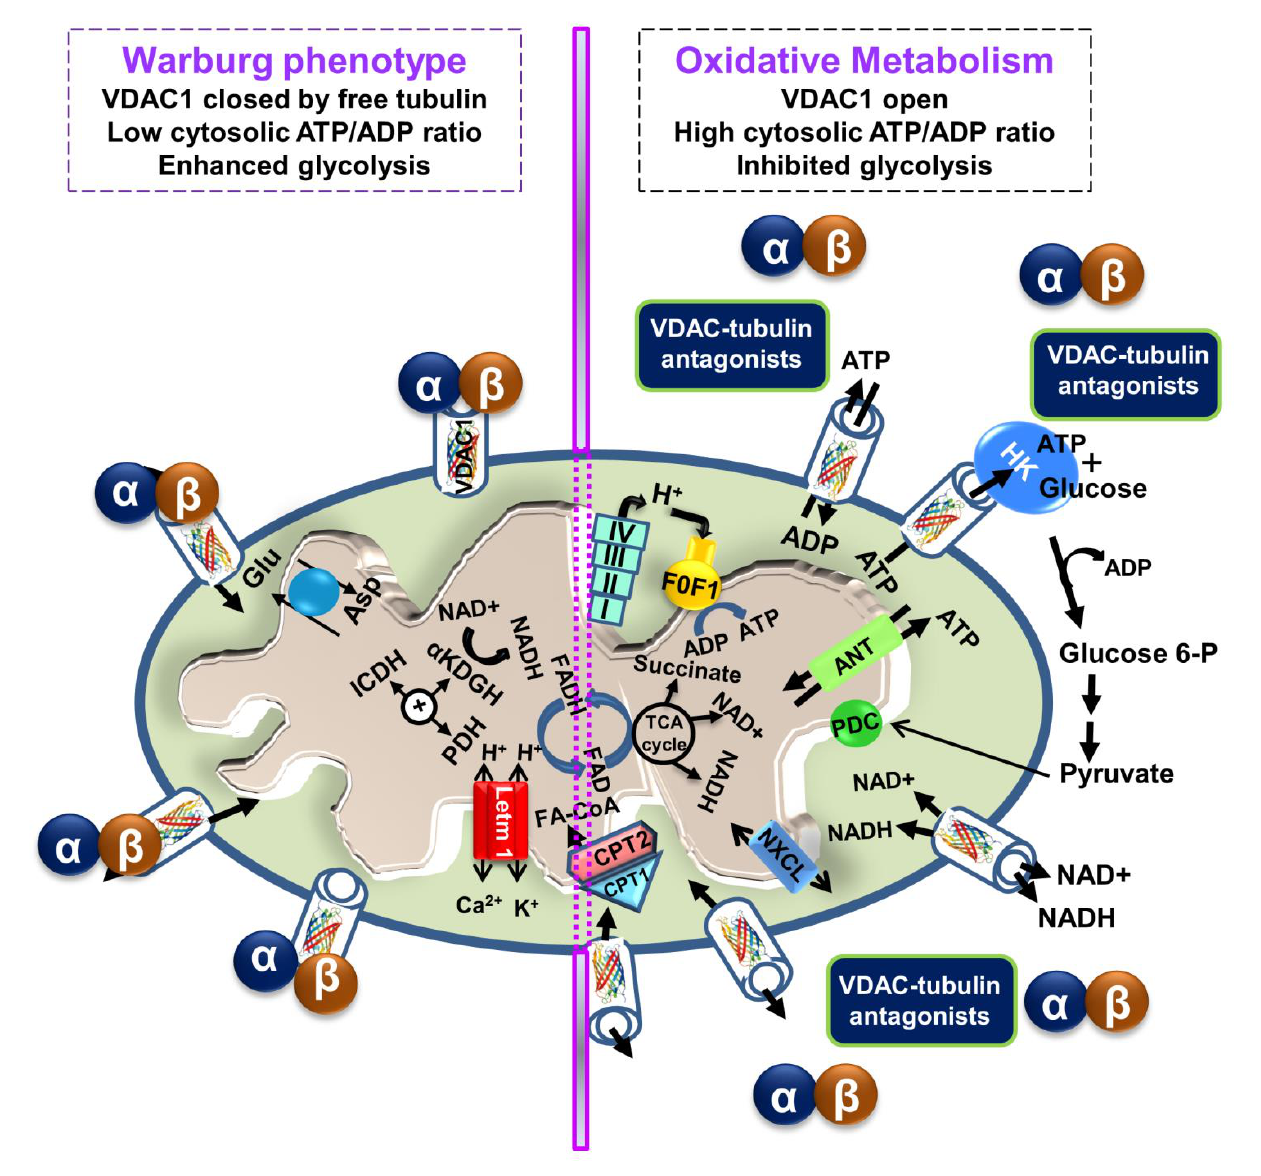
FIGURE 3: VDAC1-tubulin interaction: a metabolic switch to modulate mitochondrial metabolism in cancer cells. In cancer cells, high levels of free tubulin close VDAC1, decreasing the flux of metabolites, ATP and ADP through the OMM. VDAC1 closing leads to low generation of mito- chondrial ATP and subsequently, to a low cytosolic ATP/ADP ratio that favors glycolysis in the Warburg phenotype. Erastin, a VDAC-tubulin antagonist, opens VDAC1 by blocking the inhibitory effect of free tubulin. VDAC1 opening leads to increased mitochondrial metabolism and to a high cytosolic ATP/ADP ratio that inhibits glycolysis and reverts the Warburg phenotype. αβ indicates tubulin